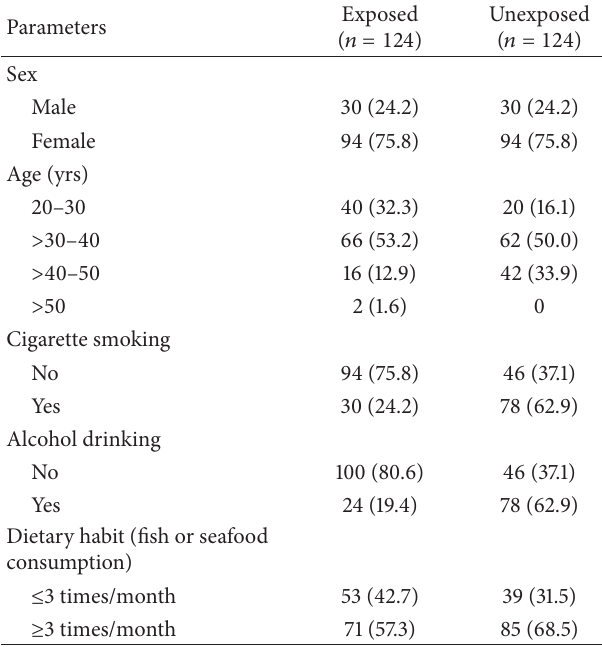
Table 1: Descriptive characteristics of the exposed and unexposed subjects ( 𝑛 = 248 ).